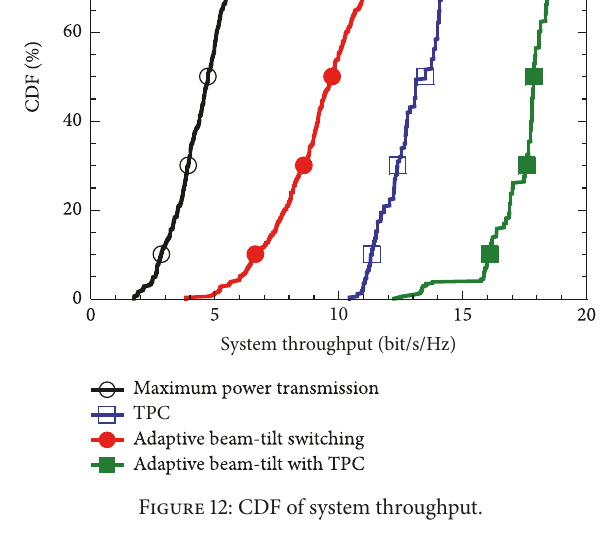
Figure 12: CDF of system throughput.